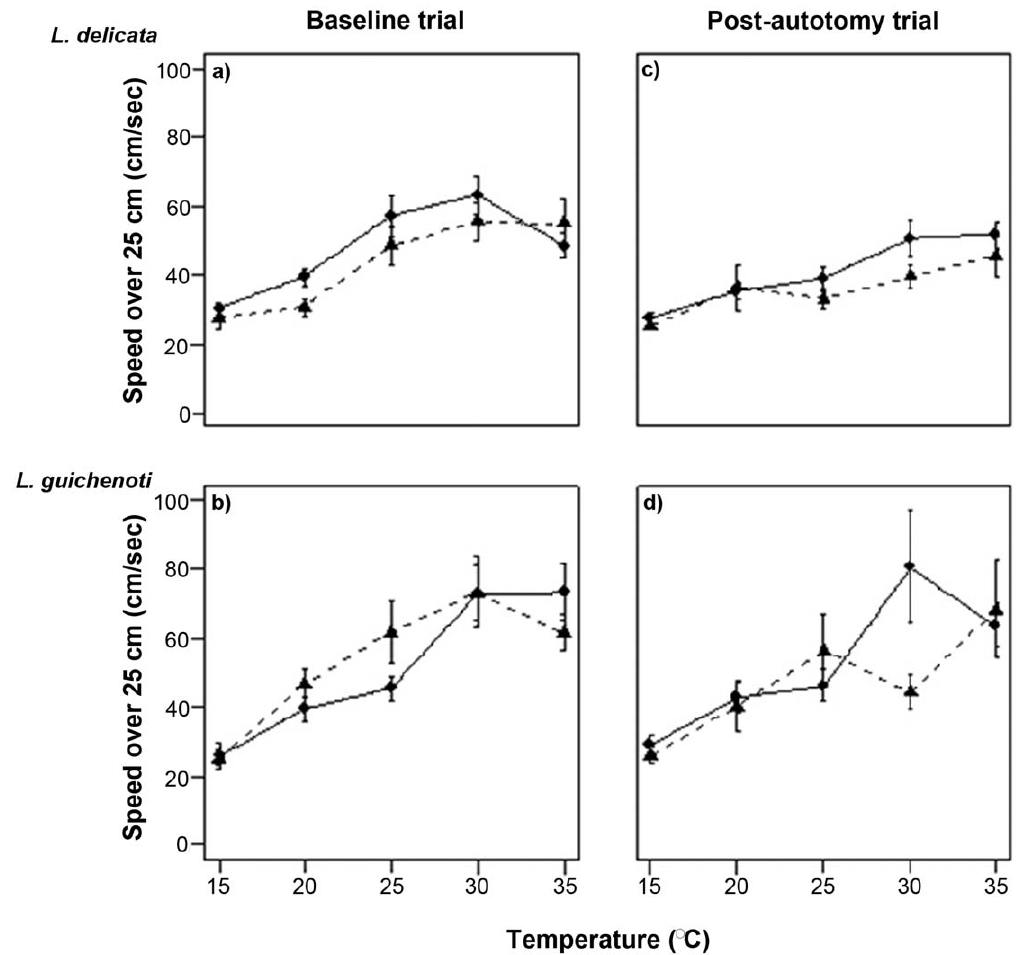
Figure 2. Impact of tail loss on maximal sprint speed in Lampropholisdelicata and L.guichenoti . The control group is represented by a solid line and circles, while the experimental group is represented by a dashed line and triangles. The baseline trials are presented on the left (a, b), with the post-autotomy trials on the right (c, d). Error bars indicate 6 1 SE.